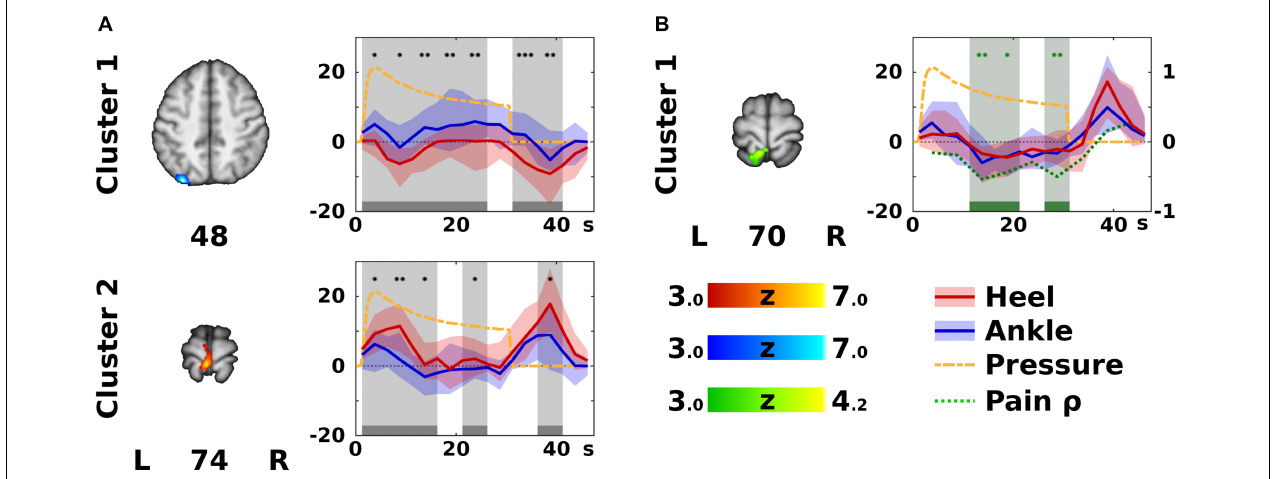
FIGURE 3 | Significant differences according to stimulation site. In panel (A) , the color Z statistical overlays represent significant F -test of within-subject differences between the heel (HS) and ankle stimulation (AS), i.e., Contrast 4 (HS – AS). The two clusters (labeled anatomically in Table 1 ) are coded either in red, if HS yielded higher activation than AS, or in blue, if the opposite was the case. The plots on the right side of each slice display median (solid dark line) and inter-quartile range (semi-transparent fill) of the modeled hemodynamic response function in the specified cluster across all subjects (HS in red, and AS in blue). Gray bars and background indicate epochs (each epoch represents one finite impulse response basis function) that significantly differed between HS and AS (Wilcoxon signed rank test). Differences were significant at uncorrected ∗ p < 0.05, ∗∗ p < 0.01, or ∗∗∗ p < 0.001 ( post hoc confirmatory analysis). For remaining conventions see Figure 2 . In panel (B) , a cluster showing significant correlation between pain difference HS – AS and activation difference (HS – AS) is displayed in green [see Contrast 5 (Pain) in the Methods]. In the corresponding timecourse plot, green bars and background indicate significant correlation according to Spearman’s correlation coefficient ( ρ ), which is plotted as a green dotted line (the ordinate range is marked on the right). Note that correlations were significant in different areas and epochs than the significant differences between activation levels in HS and AS. For remaining conventions see panel (A)